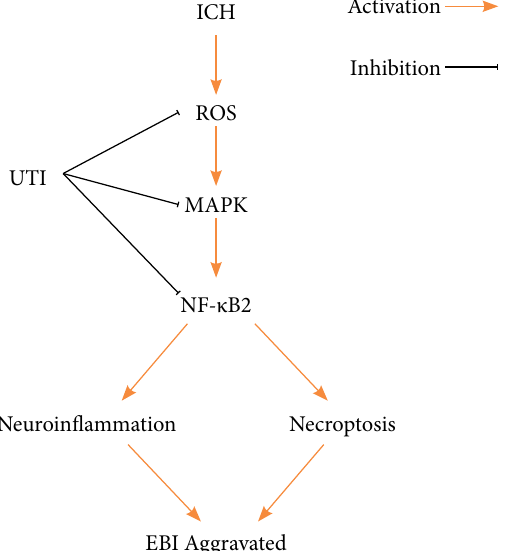
Figure 7 - A diagram of the proposed model explaining the observations of MAPK/NF- κ B -mediated regulation of necroptosis, and neuroinflammation after ICH and potential mechanisms underlying the effect of the UTI